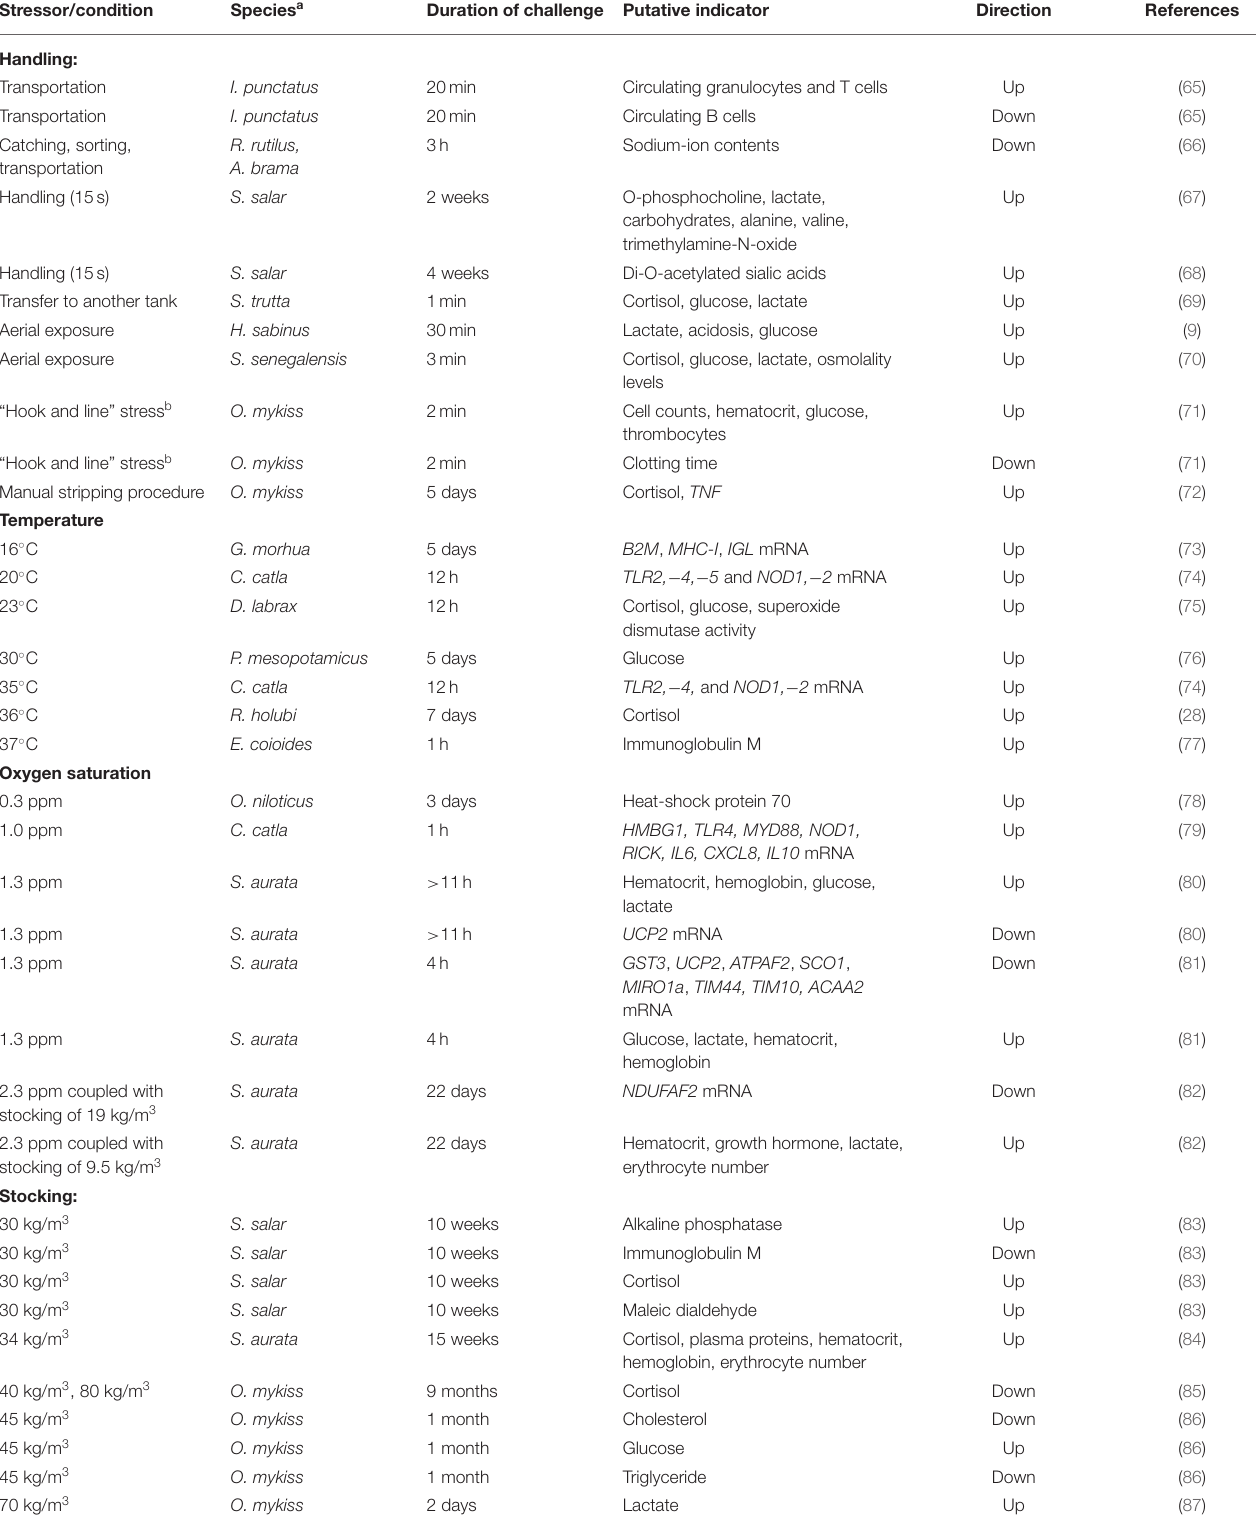
TABLE 1 | Overview of the selected physiological parameters that change in blood, plasma, or serum in response to stressful conditions in various fish species. Stressor/condition Species a Duration of challenge Putative indicator